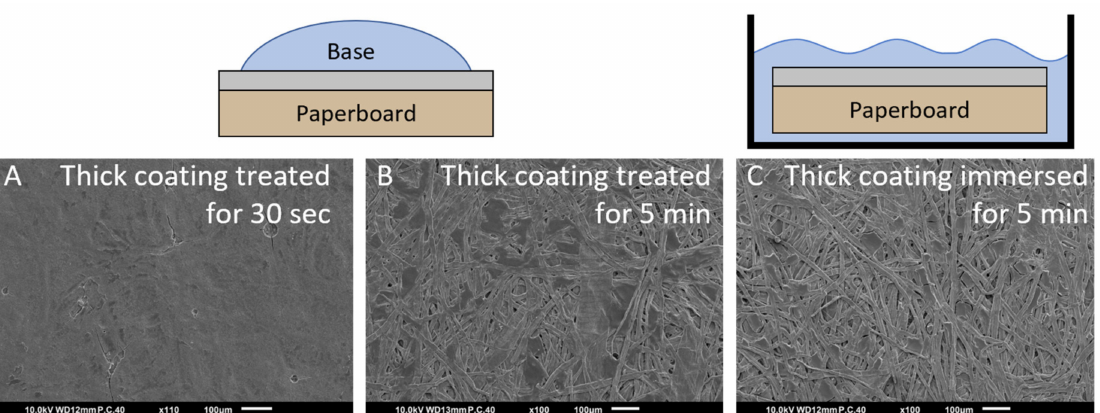
Figure 9. SEM images of the single thick coating on paperboard treated with 0.1 M NaOH (aq) by placing a droplet on top of the coated paperboard for ( A ) 30 s and ( B ) 5 min. Additionally, ( C ) the single thick coated paperboard was immersed in 0.1 M NaOH solution for 5